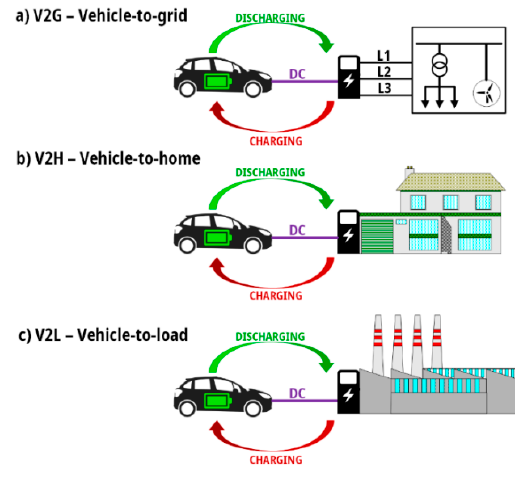
Figure 1. Various forms of Vehicle-to-X technology.